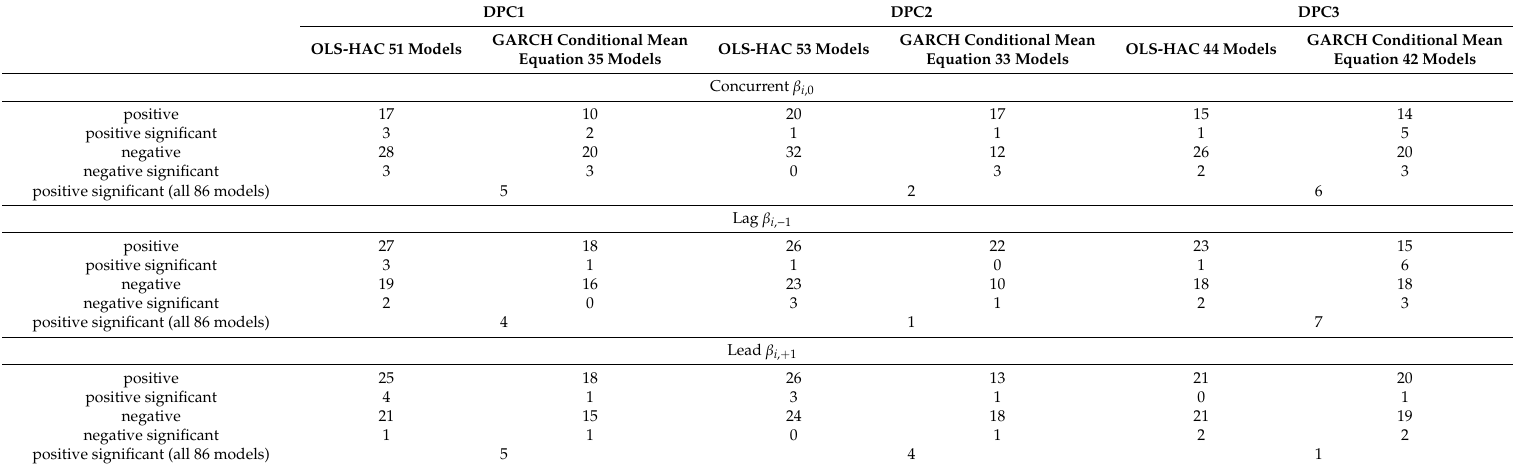
Table 6. Testing for commonality in liquidity on the WSE within the whole sample period 2 January 2005–30 December 2016 (3005 trading days) with the principal components PC1–PC3 as latent liquidity